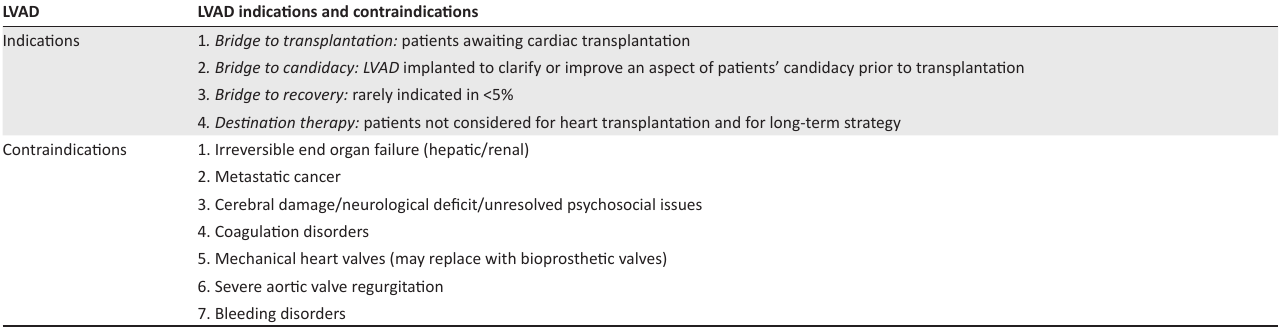
TABLE 2: Indications and contraindications for left ventricular assist devices. LVAD